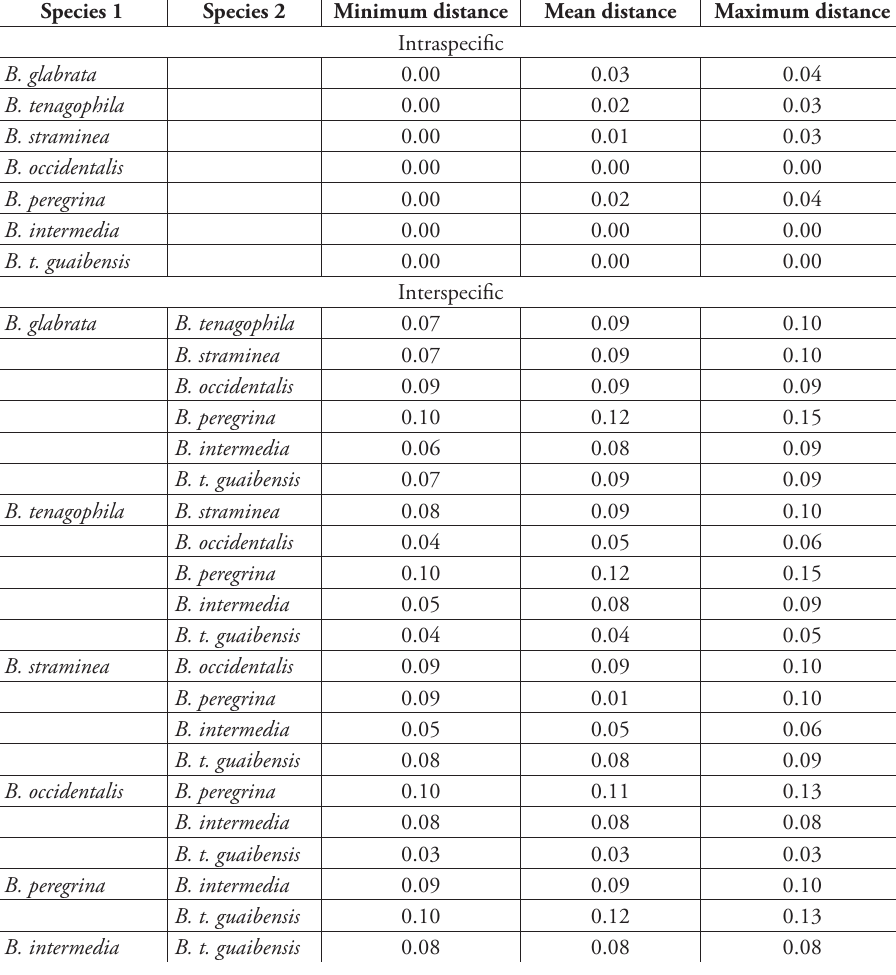
Table 4. Intraspecific and interspecific genetic distances (COI) generated using the Kimura 2-parameter model (K2P, Kimura 1980) in MEGA6 (Tamura et al.